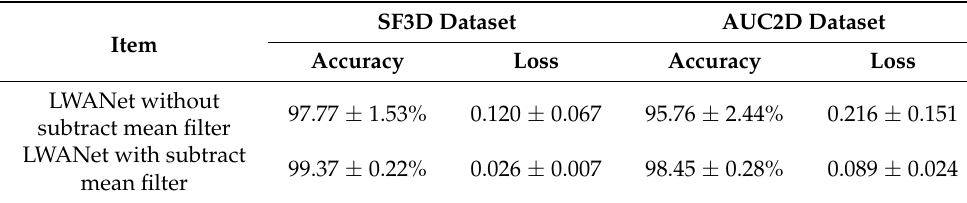
Table 2. Comparing the Effectiveness of the Subtract Mean Filter.